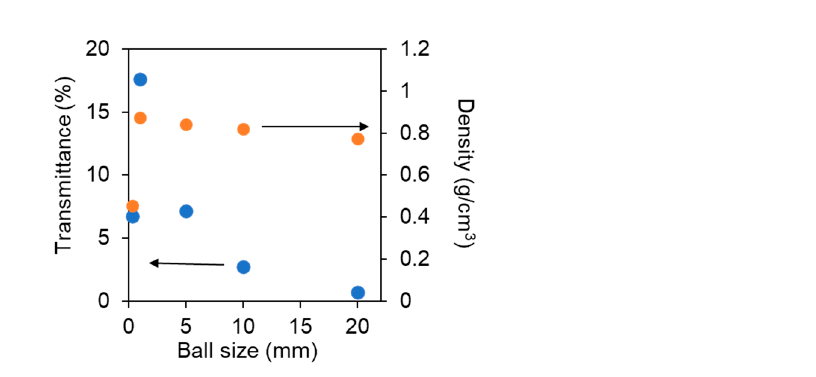
Figure 2. Dependence of transmittance at 600 nm (blue circle) and density (orange cercle) of the cast film on different ball sizes for milling of chitin.